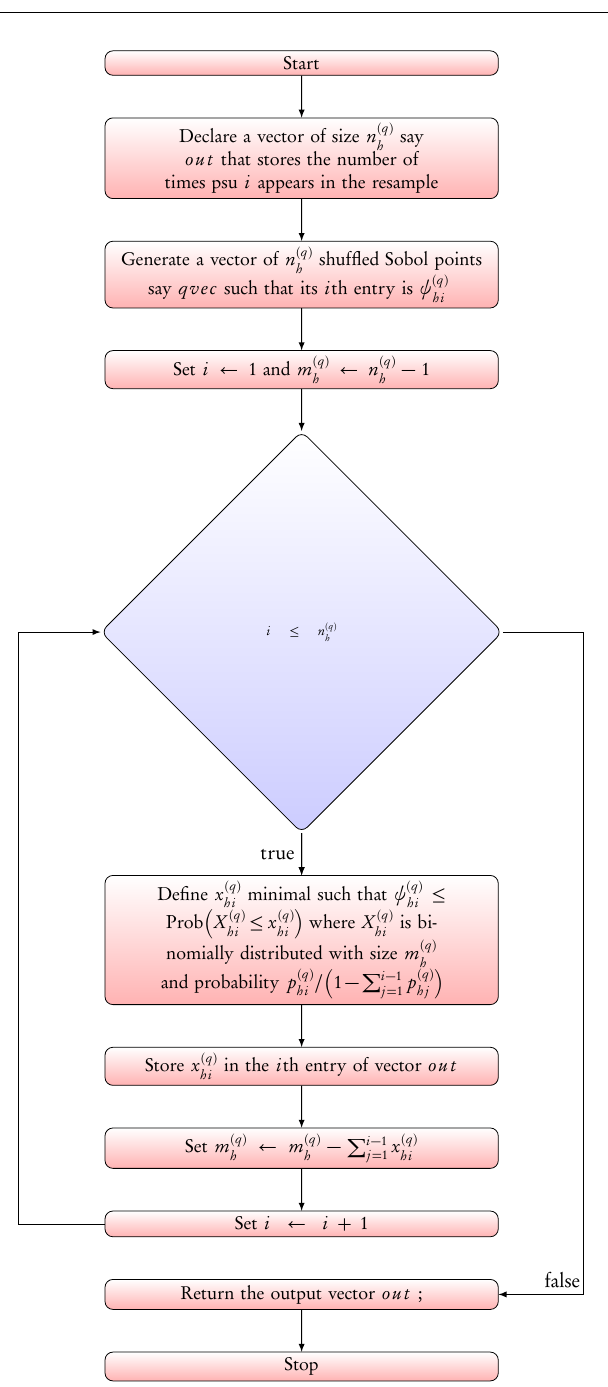
∗ ( q ) through the first algorithm steps h